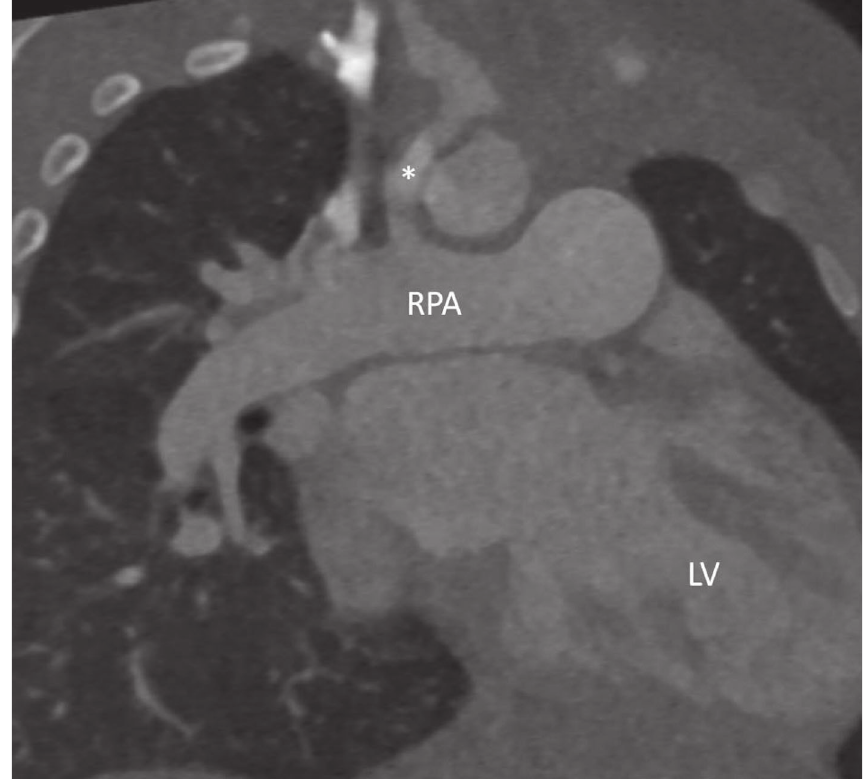
Figure 4: An oblique coronal image from contrast enhanced cardiac CTshowing a right modified Blalock-Taussig shunt ( ∗ ), dilated right pulmonary artery (RPA), left atrium, and LV. Note the abnormal LV trabeculations along the LV inferior, lateral and apical